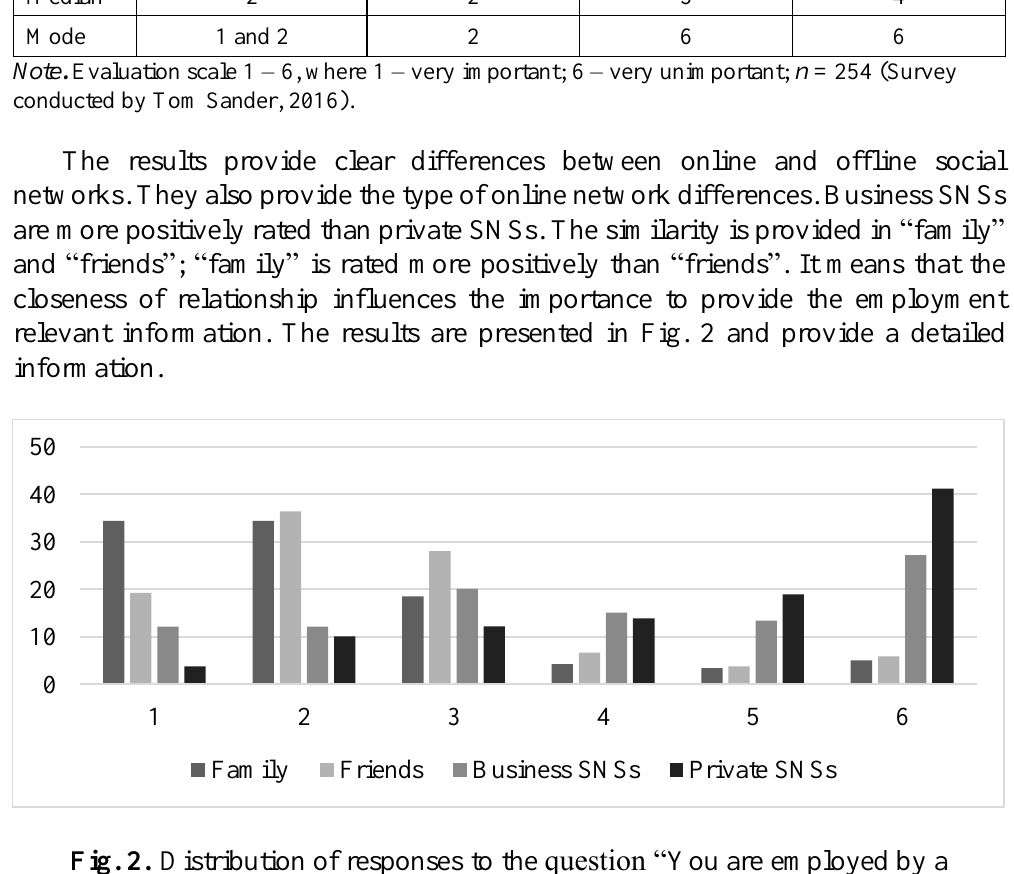
Fig. 2. Distribution of responses to the question “You are employed by